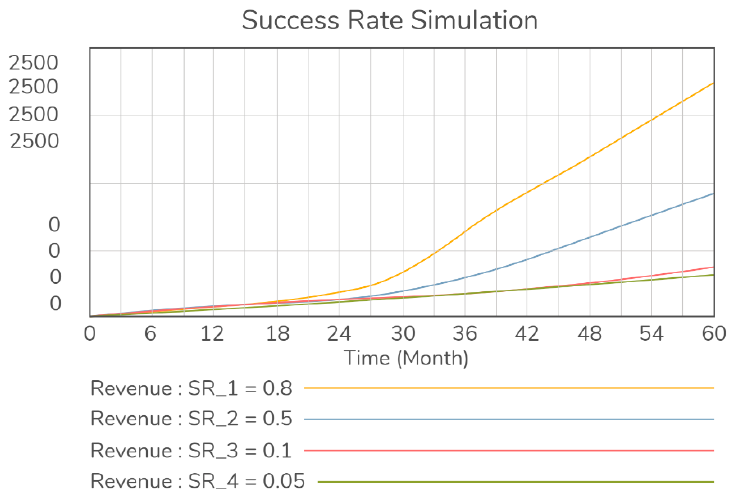
Figure 9. The OI simulation with four different Success Rates (SR). In opposition, the dummy variable, beta, represents the failure rate with the same logic for the revenue as described in Figure 10.